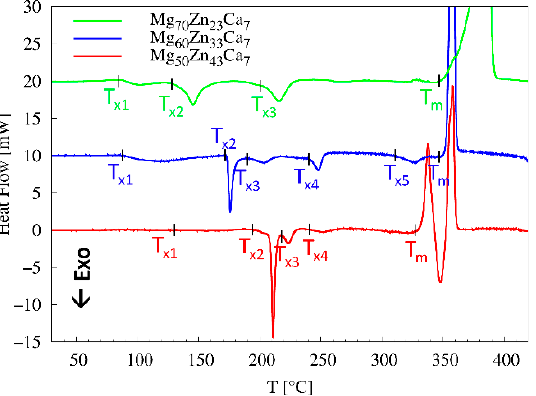
Figure 5. The DSC curves for Mg 70 Zn 23 Ca 7 , Mg 60 Zn 33 Ca 7 , and Mg 50 Zn 43 Ca 7 (from top to bottom). Individual curves are vertically offset for clarity reasons.